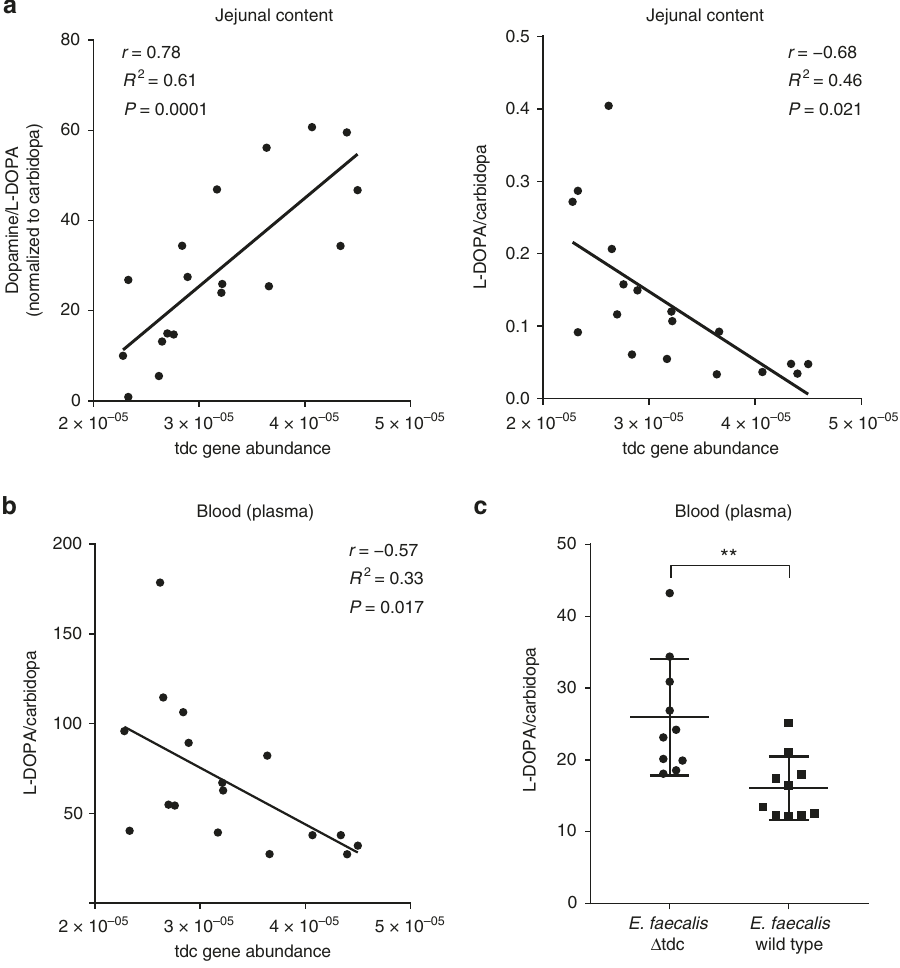
Fig. 6 Luminal and plasma levels of levodopa are compromised by higher abundance of tyrosine decarboxylase gene in the small intestine of rats. Scatter plot of tdc gene abundance measured by qPCR in jejunal content of wild-type Groningen rats ( n = 18) orally supplied with levodopa/carbidopa mixture (4:1) versus a the dopamine: levodopa/carbidopa levels in the jejunal content, the levodopa/carbidopa levels in the jejunal content, b or the levodopa/ carbidopa levels in the plasma, fi tted with a linear regression model. Intake of levodopa/carbidopa was corrected by using carbidopa as an internal standard. Pearson ’ s r correlation was used to determine signi fi cant correlations between tdc abundance and jejunal dopamine levels ( r = 0.78, R 2 = 0.61, P value = 0.0001), jejunal levodopa/carbidopa levels ( r = − 0.68, R 2 = 0.46 P value = 0.021), or plasma levodopa/carbidopa levels ( r = − 0.57, R 2 = 0.33, P value = 0.017). No levodopa/carbidopa, dopamine, or DOPAC were detected in the control group ( n = 5). c Signi fi cant difference in plasma levels of levodopa/carbidopa orally supplied to rats after treatment with EFS WT ( n = 10) or EFS Δ TDC ( n = 10). Signi fi cance was tested using parametric unpaired T - test (** p <